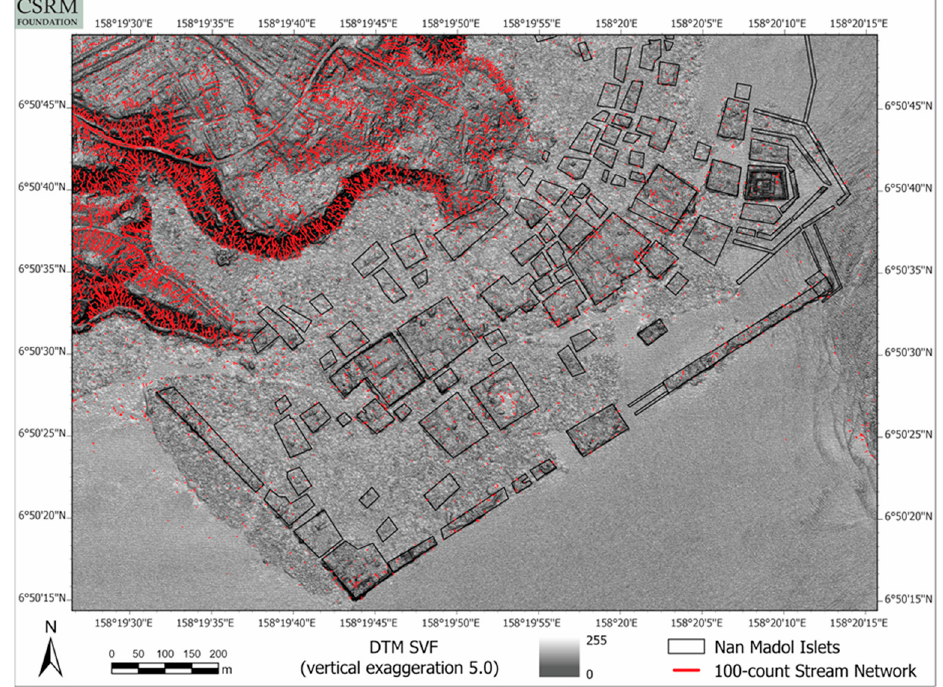
Figure 13. A stream network model (described in subsection 2.2). Water flowing along the southern edge of Temwen and along the slopes of the ravine to the northwest of Nan Madol is funneled into the site.